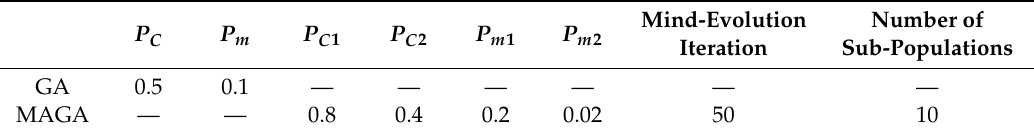
Table 6. Setting parameters of different algorithms.